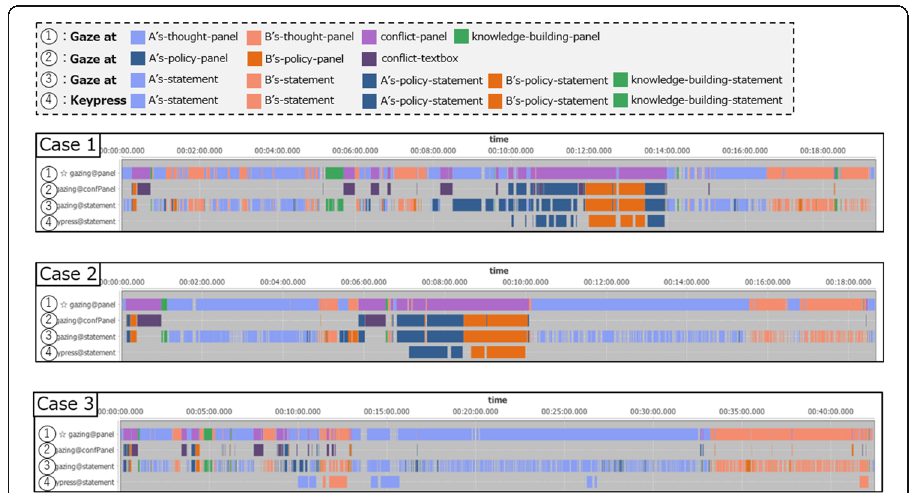
Fig. 7 Result examples of applied lower-level interpretation